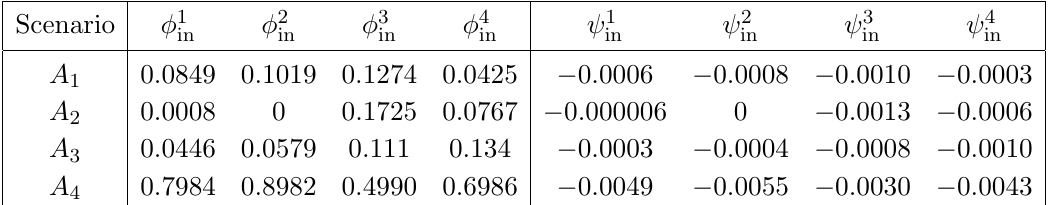
Table 2. Initial conditions ((cid:12)elds in units of M Pl ) at N (cid:3) table